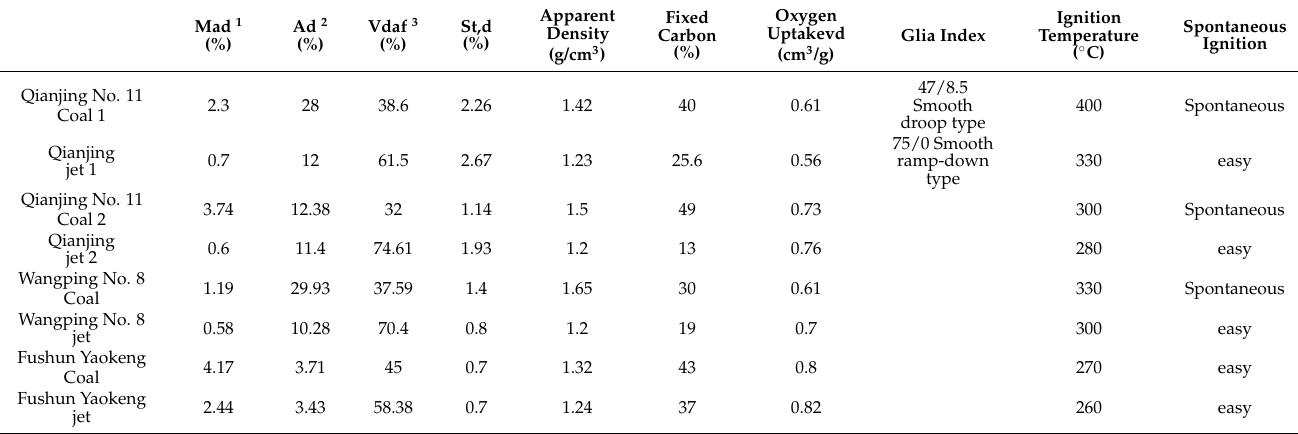
Table 1. Comparison of the results of the coal and jet test results for each coal